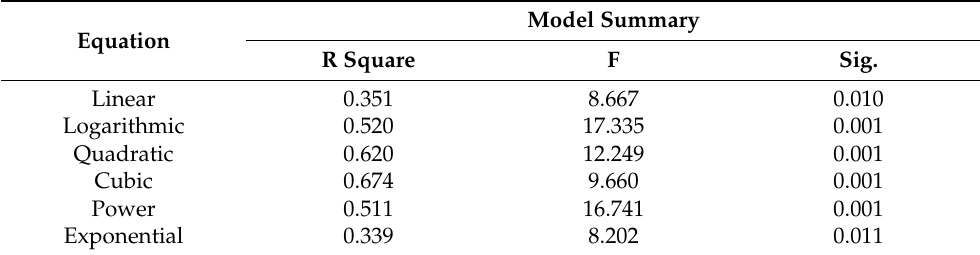
Table 4. The summary of the regression